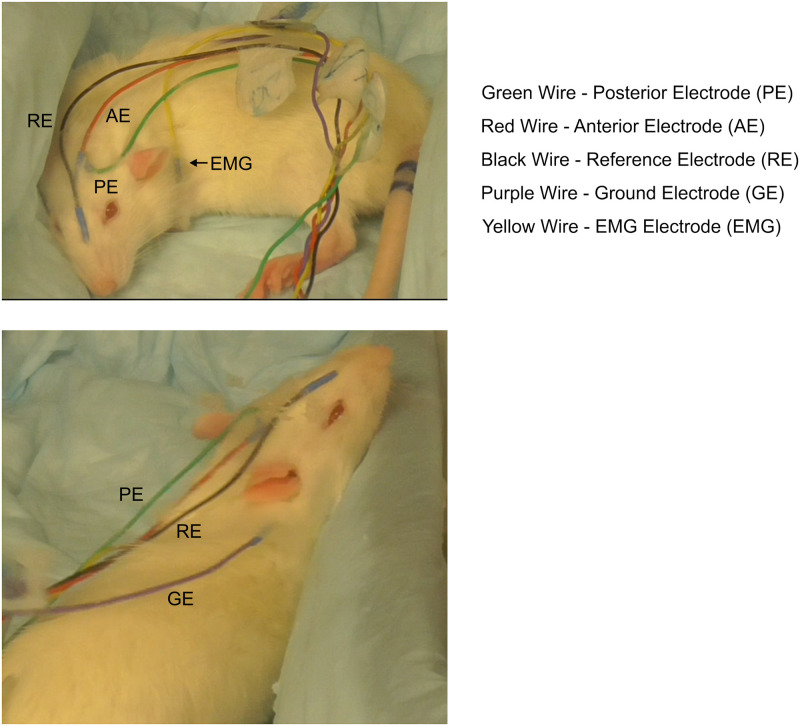
Photograph showing placement of EEG electrodes.The two photographs of the same rat were obtained as the animal was emerging from anesthesia. Two channels of EEG signals analyzed in this study were the difference between the reference electrode (Black wire) labeled RE and either the anterior electrode (Red wire) labeled AE or the posterior electrode (Green wire) labeled PE. Muscle movements were obtained from the EMG electrode (Yellow wire) labeled EMG. The ground electrode was labeled as GE (Purple wire).